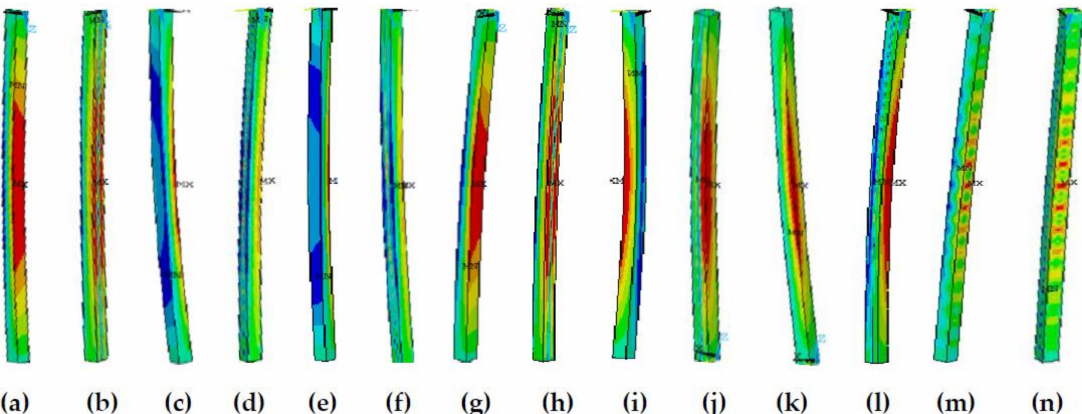
Figure 18. The buckling equivalent stress cloud diagram when λ = 80. ( a ) b / t = 10, ( c ), b / t = 15, ( e ) b / t = 20, ( g ) b / t = 25, ( i ) b / t = 35, ( k ) b / t = 40, and ( m ) b / t = 50 without residual stress; ( b ) b / t = 10, ( d ) b / t = 15, ( f ) b / t = 20, ( h ) b / t = 25, ( j ) b / t = 35, ( l ) b / t = 40, and ( n ) b / t = 50 with residual